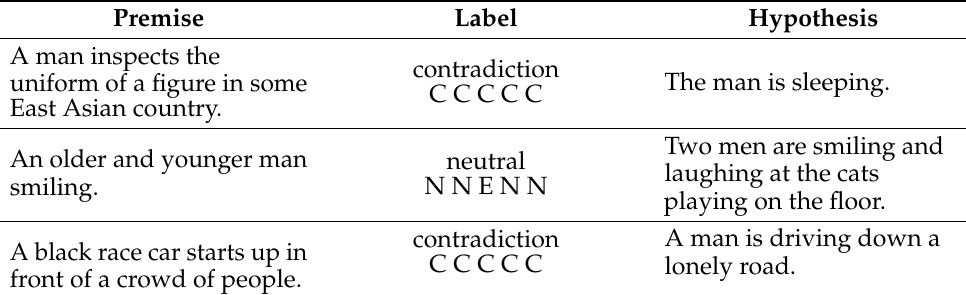
Table 4. Example data from SNLI corpus.